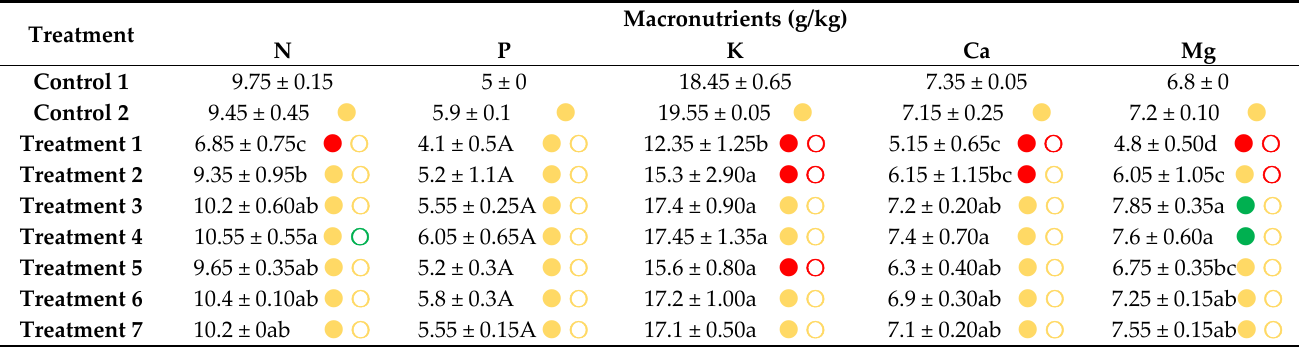
Closed ( ⬤ ) and open ( 〇 ) circles indicate comparisons withs Controls 1 and 2, respectively. Green, yellow, and red circles indicate that the values are higher than, equivalent to, or lower than those observed in the controls, according to the Kruskal–Wallis test ( p ≤ 0.05) and pairwise comparison with the Dunn test ( p ≤ 0.05). Means followed by the same letter do not differ statistically. Control 1: control without inoculation + fertilization 100% of N and P; Control 2: control without inoculation + fertilization 30% of N and P; Treatment 1: Azospirillum brasilense (Ab-v5), Treatment 2: Bacillus megaterium (0004); Treatment 3: Brevibacillus fluminis (MET12M2); Treatment 4: Ab-v5 + 0004; Treatment 5: Ab-v5 + MET12M2; Treatment 6: 0004 + MET12M2; Treatment 7: Ab-v5 + 0004 + MET12M2.